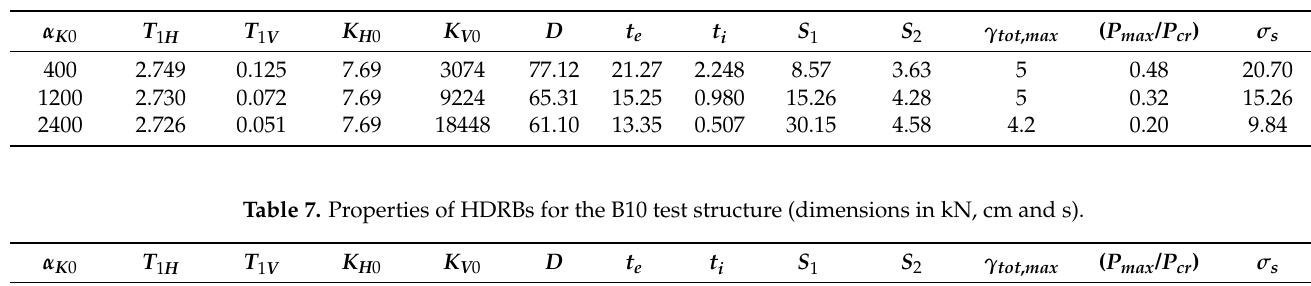
Table 6. Properties of HDRBs for the B7 test structure (dimensions in kN, cm and s).